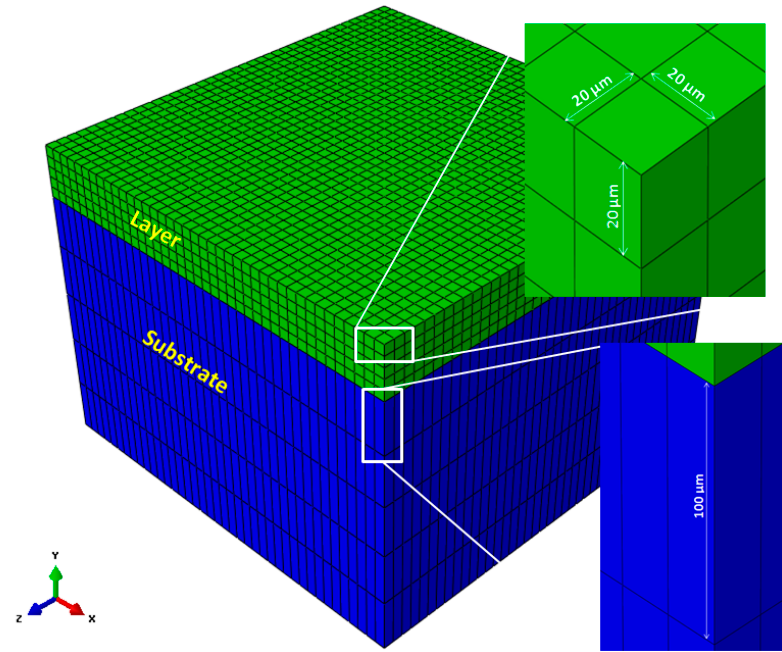
Figure 3. Single layer of Ti-64 on top of a substrate. In this particular case, the substrate material is also Ti-64. Element sizes in layer and substrate are shown by zooming associated elements.